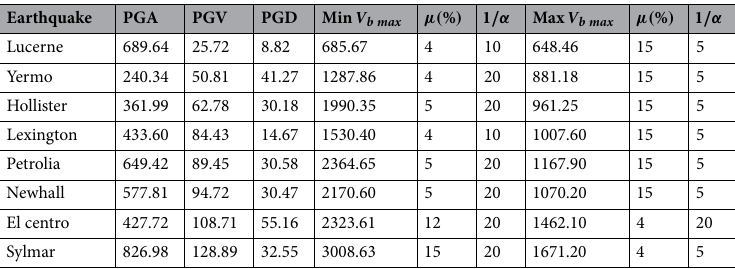
Table 3. Isolation system parameters that give smallest max. base shear.